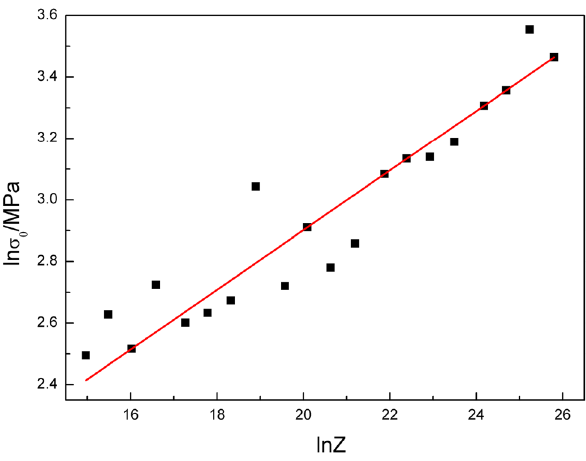
Figure 9: Linear dependence between ln σ 0 and ln Z .